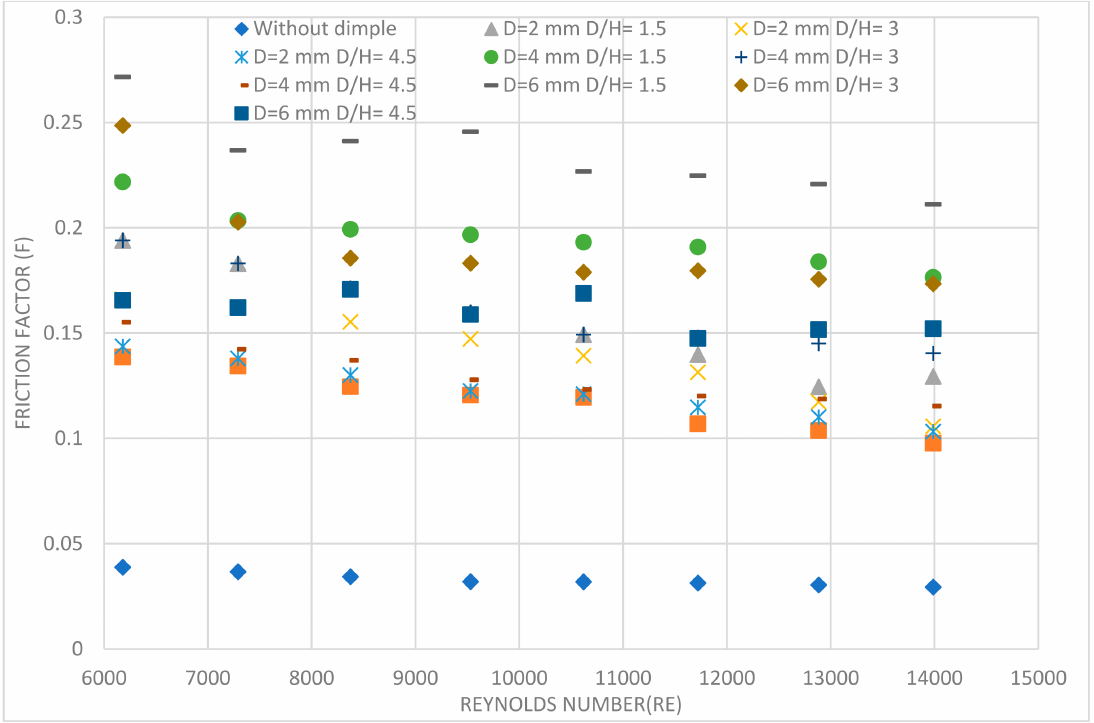
Figure 12. Experimental validation of Friction factor Vs Reynolds number at various values of D/H ratio’s (1.5, 3 and 4.5) and different Dimple Diameter (2, 4 and 6 mm). A range of Reynolds number was plotted against all the investigational values collected for ‘Nu’ with dimple geometry, indicating that a direct correlation among ‘Nu’ and ‘Re’ would almost occur. For the data presented, a regression analysis was performed, and bend fitting was used to calculate mean line of all